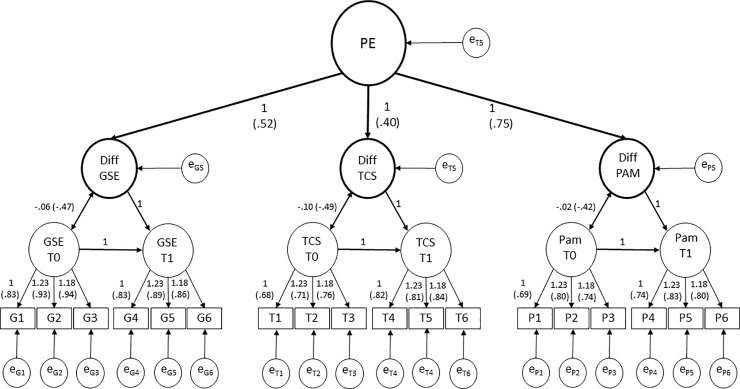
Hierarchical model.Identification of Patient Empowerment through Self-Efficacy, Transition Competence and Patient Activation Unstandardized factor loadings (Standardized factor loadings). All results p < .001. PE = Patient Empowerment, GSE = General Self-Efficacy, TCS = Transition Competence Scale, PAM = Patient Activation Measurement–German Youth Version. Diff GSE = latent Difference of General Self-Efficacy, Diff TCS = latent Difference of Transition Competence Scale, Diff PAM = latent Difference of Patient Activation Measure.